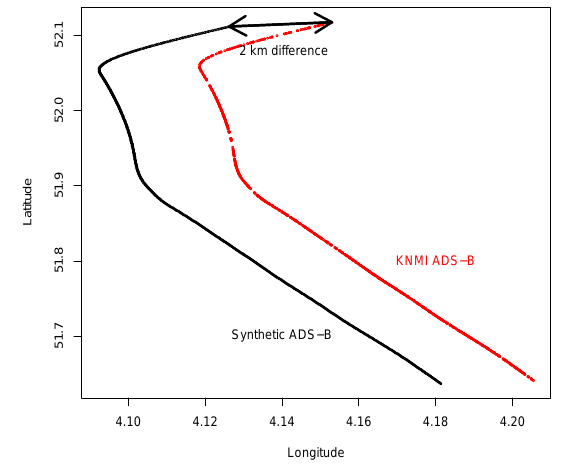
Figure 5. Comparison of ground speed record against estimates based on reported geographic position for the case of FL8. FL8 is presented because of the longest continuous KNMI record contain- ing ground